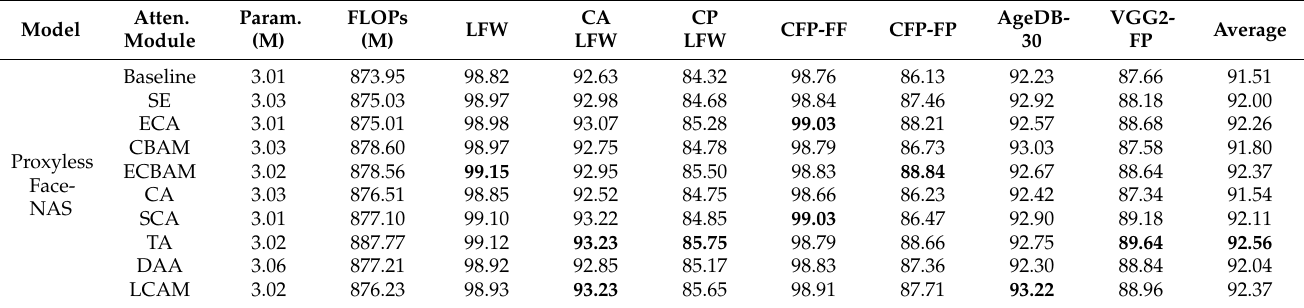
Table 11. Performance results of different attention modules plug into ProxylessFaceNAS. These results are reported in terms of parameters, FLOPs and verification accuracy for LFW, CALFW, CPLFW, CFP-FF, CFP-FP, AgeDB-30, and VGG2-FP. Moreover, the average accuracy for the seven image-based datasets is shown in the last column. (Bold values are the highest obtained values by the